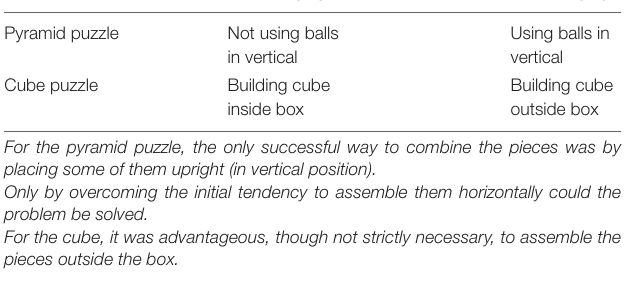
fixation (=0) in vertical